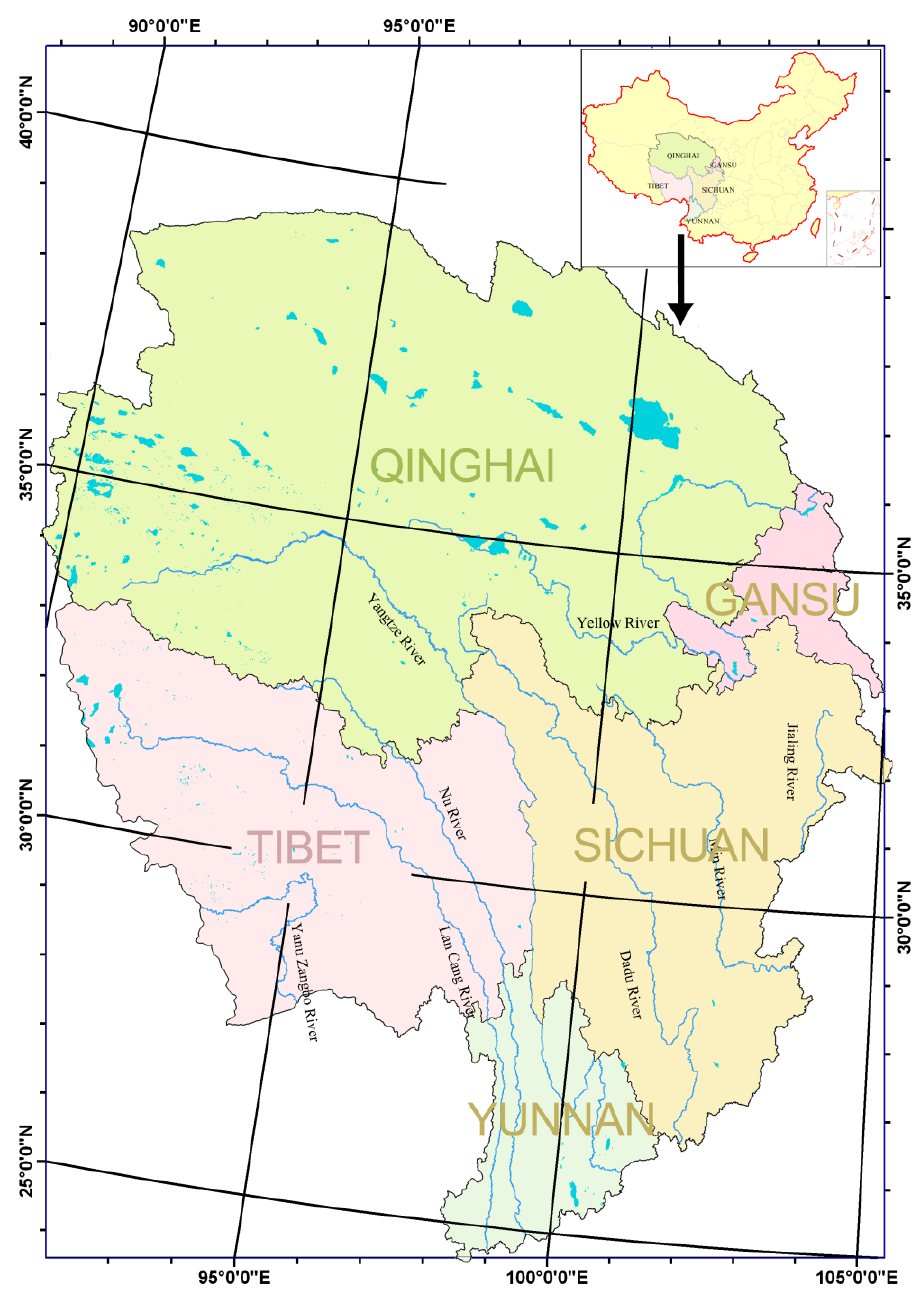
Figure 1. Geographical setting of eastern Tibetan Plateau (China) including five provinces of China: Qinghai province, part of Xizang (Tibet), Sichuan, Gansu and Yunnan provinces. Several major rivers originate there, including the Yanu Zangbo River, Lancang River, Nu River, Yellow River, Yangtze River, Dadu River, Min River and Jialing